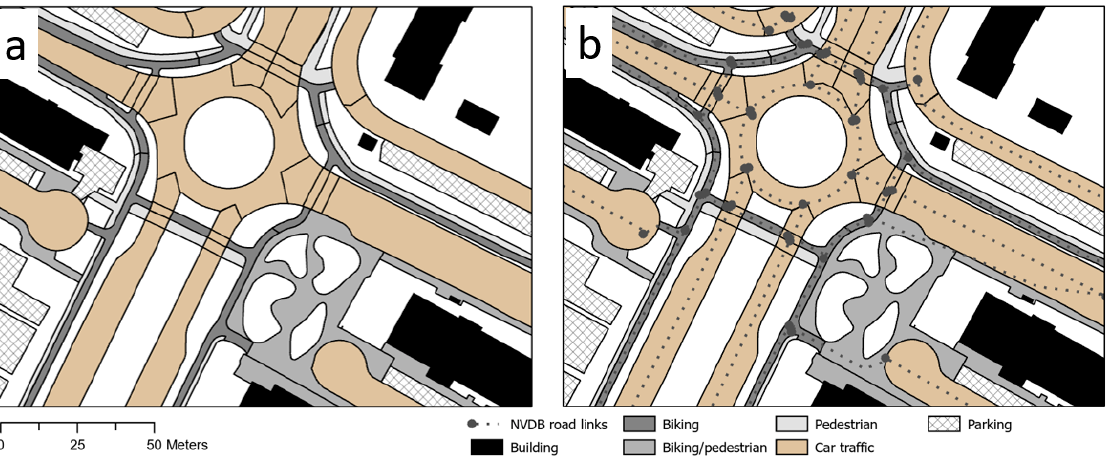
Figure 11. Traffic areas from the transportation theme according to 3CIM without ( a ) and including ( b ) the road links from The National Road Database (NVDB). Buildings are included for illustration purposes.